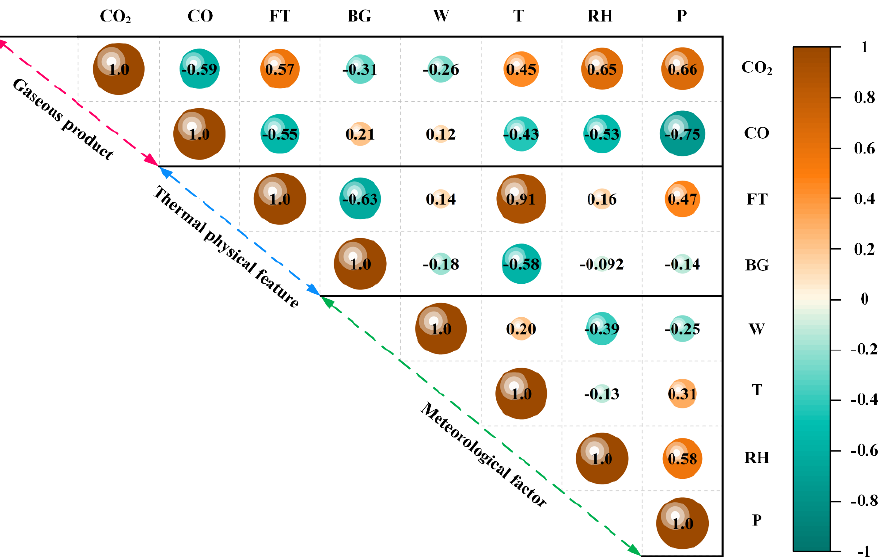
CO), meteorological factors, and thermophysical characteristics. FT: fracture temperature; BG: bidirectional gas velocity; W: wind velocity; T: temperature; RH: relative humidity; P: air pressure. Correlation coefficients: no correlation (0 ≤ |r| < 0.2); weak correlation (0.2 ≤ |r| < 0.4); moderately significant correlation (0.4 ≤ |r| < 0.6|); strong correlation (0.60 ≤ |r | < 0.80); very strong correlation (0.80 ≤ |r| < 1.0). Positive correlations are displayed as brown balls, and negative correlations are shown as green balls. The larger and darker ball corresponds to two factors, indicating a stronger correlation between them, and the smaller and lighter ball corresponds to two factors, indicating a weaker correlation between